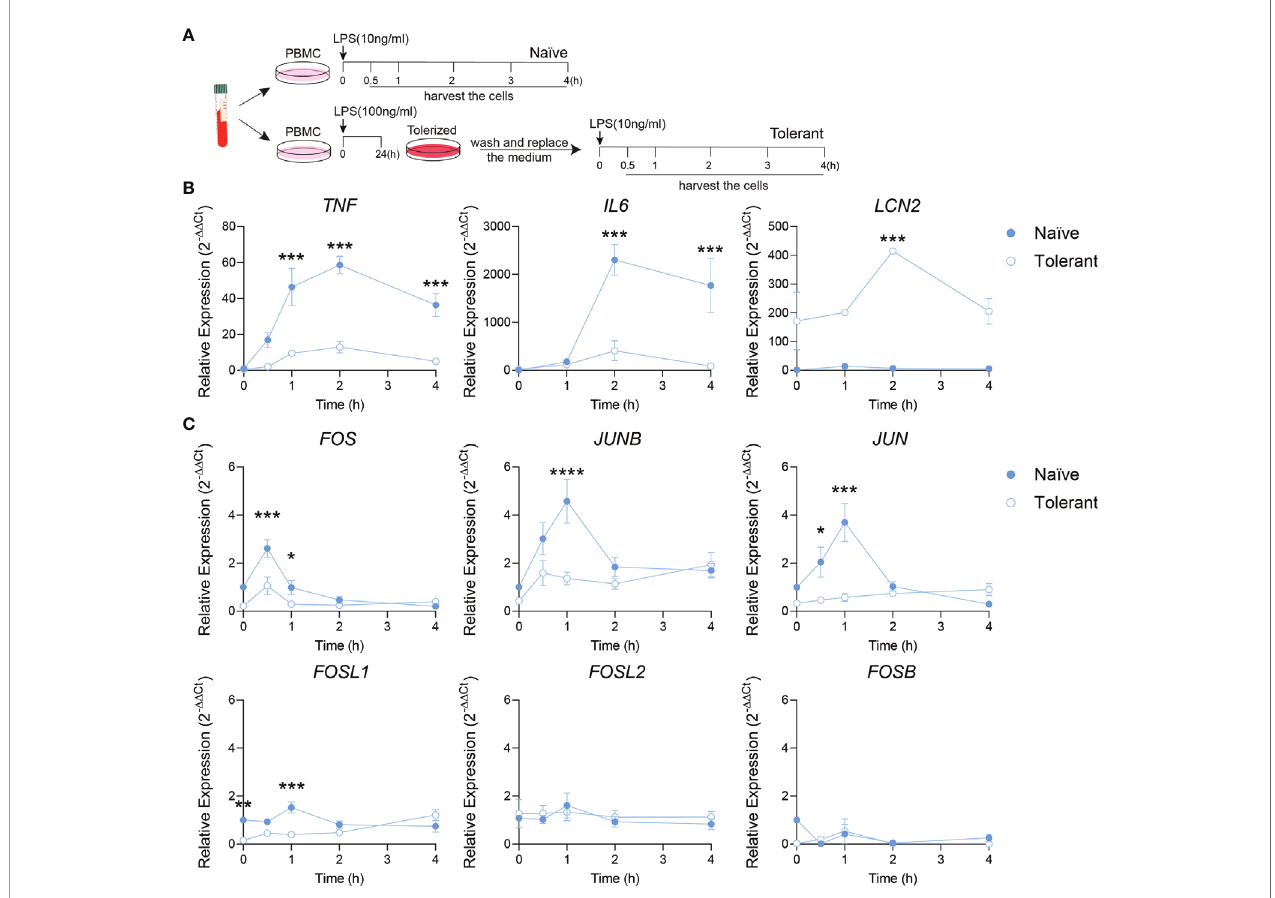
FIGURE 2 | Fosl1 expression is altered after induction of endotoxin tolerance in human peripheral blood mononuclear cells. (A) Experimental scheme of the induction of endotoxin tolerance response in human PBMC. A kinetic analyses of gene expression was performed at the indicated time point in PBMC harvested following one (Naïve) or two (Tolerant) LPS stimulations. (B) Quantitative RT-PCR analysis of tolerizable genes ( TNF, IL6 ) and non-tolerizable genes ( LCN2 ), normalized to the expression of Actb . (C) Quantitative RT-PCR analysis of AP-1 transcription factor genes, normalized to the expression of Actb . Data are shown as mean ± s.e.m. *p < 0.05; **p < 0.01; ***p < 0.001; ****p < 0.0001 by two-way RM ANOVA with Tukey ’ s multiple comparisons test. The data shown are from one experiment representative of three independent biological